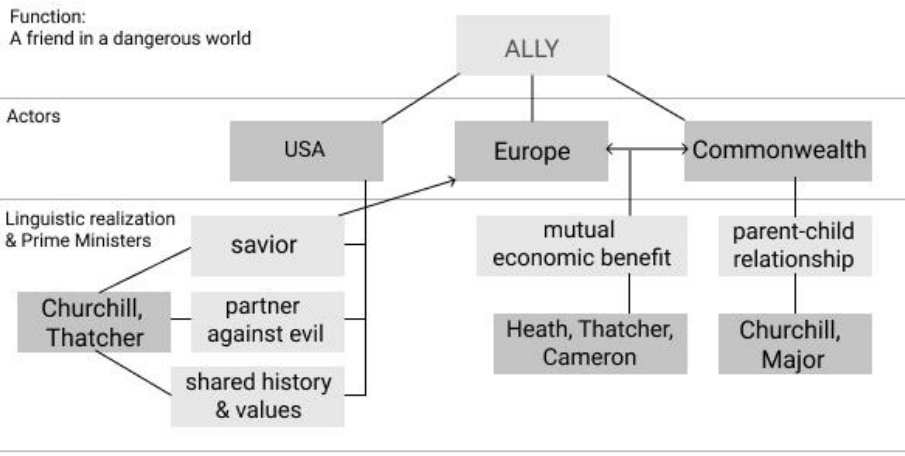
Figure 3. Discursive Strategy of Ally Creation.